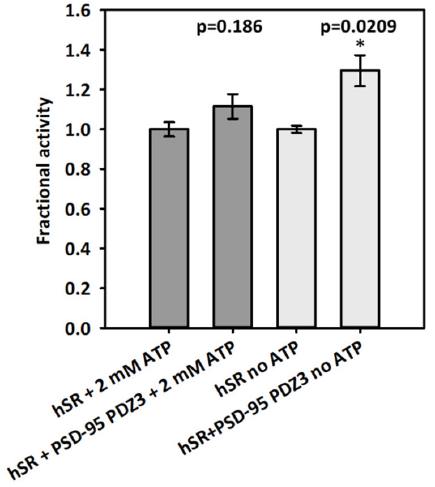
Figure 5. Effect of PSD-95 PDZ3 on hSR activity, in the presence (dark grey bars) and absence (light grey bars) of ATP. The fractional activity is reported setting as 1 the activity without PSD-95 PDZ3 either with 2 mM ATP or without ATP. All experiments were performed in triplicate. The p values from the statistical analysis of the sets of experiments with or without ATP are reported on the graph. The symbol * indicates a statistically significant difference between the two fractional activities with or without PSD ‐ 95 PDZ3 in the absence of ATP.